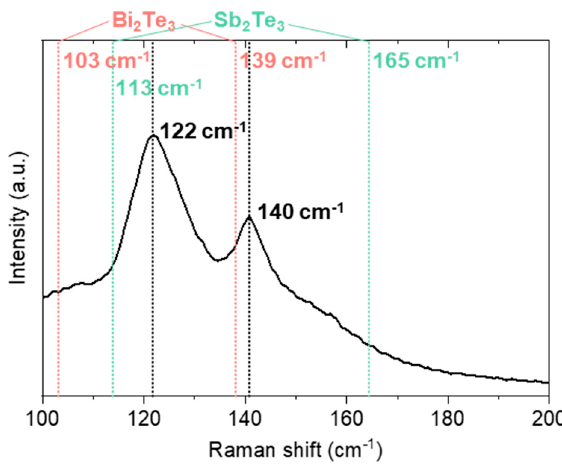
Figure 2. Raman spectra of the as-synthesized BST NPs.